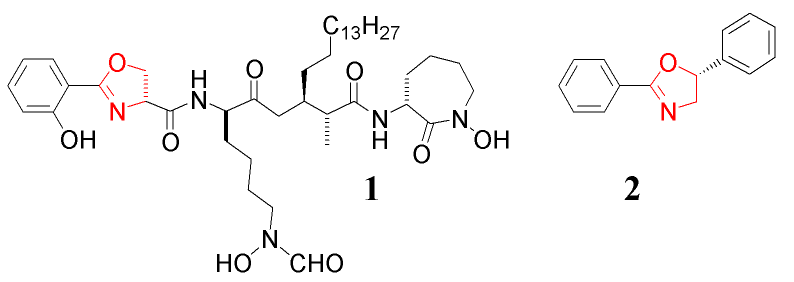
Figure 1. The molecular structures of the natural products Brasilibactin A ( 1 ) and Oxytriphine ( 2 ).